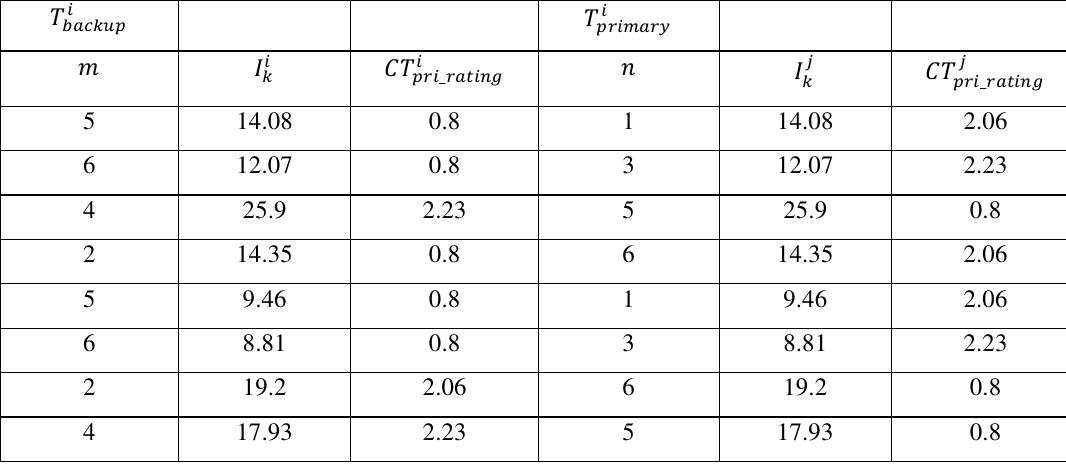
TABLE 6: CURRENT TRANSFORMER RATING AND DIFFERENT TIME SETTINGS OF BACKUP AND PRIMARY